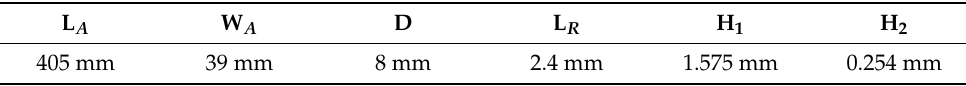
Figure 5. Configuration of the 2 × 2 square patch array: ( a ) front view and ( b ) side view. Table 2. Dimensions of feeding-antenna